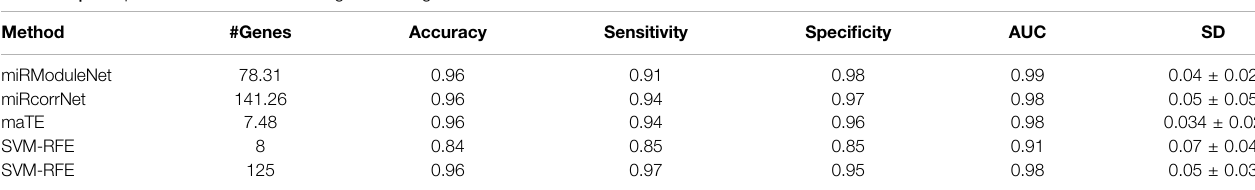
TABLE 6 | Comparative evaluation of existing tools using 11 cancer datasets.